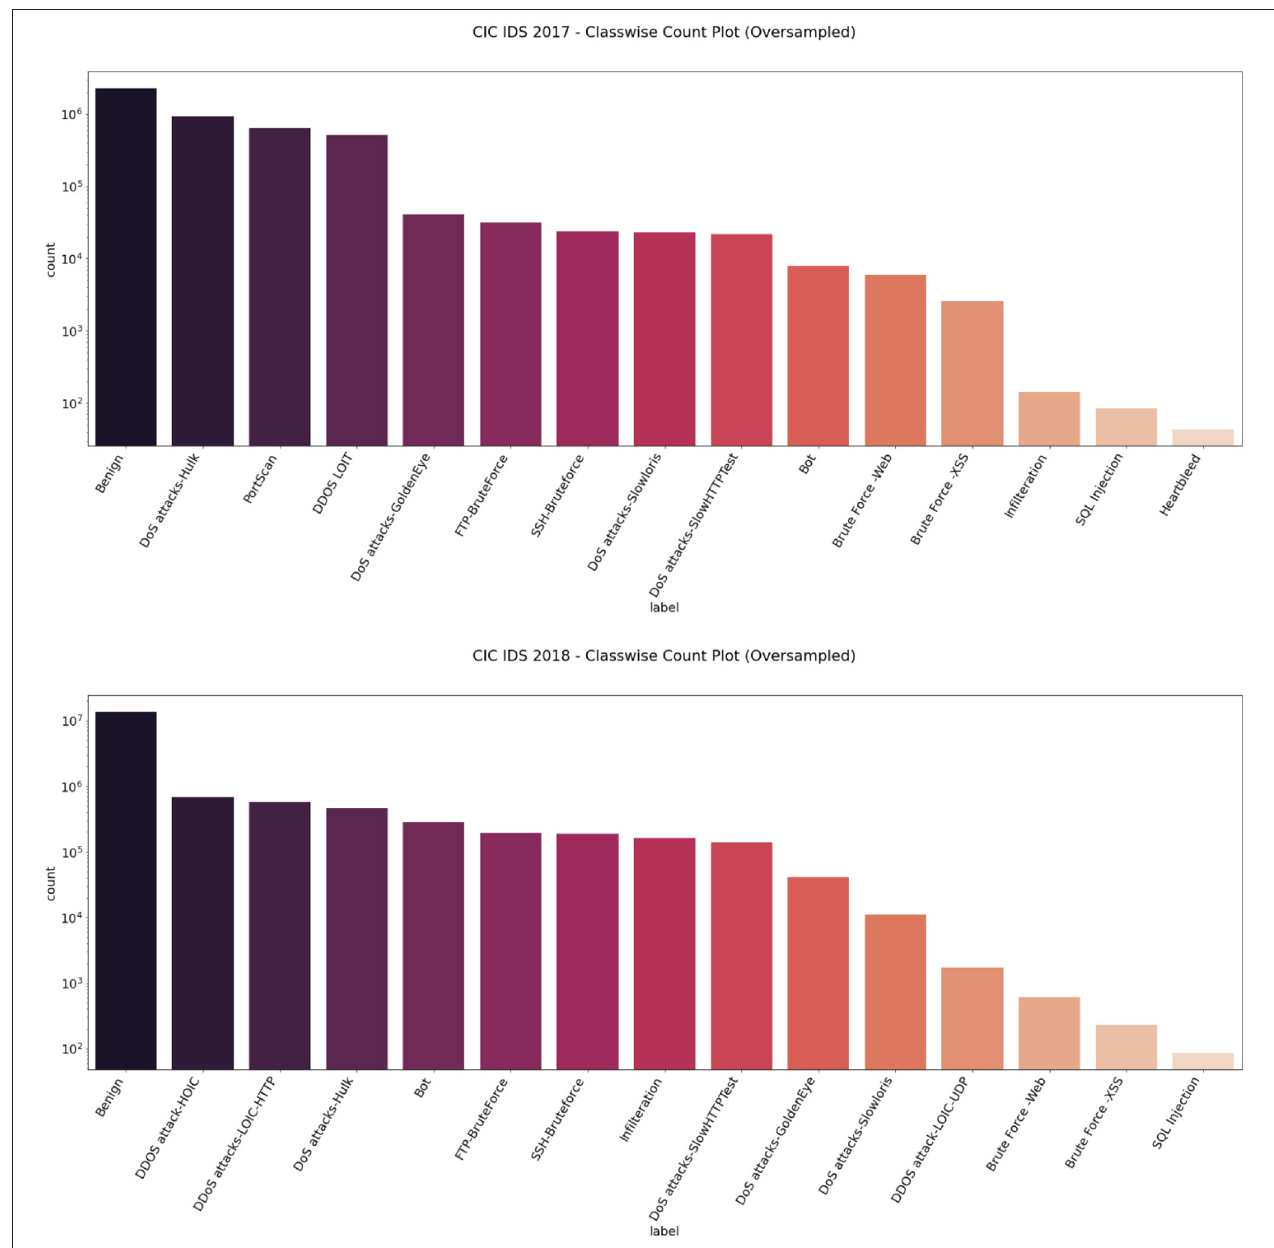
FIGURE 6 | Classwise count plot of oversampled CIC IDS 2017 (top) and 2018 (bottom) datasets.